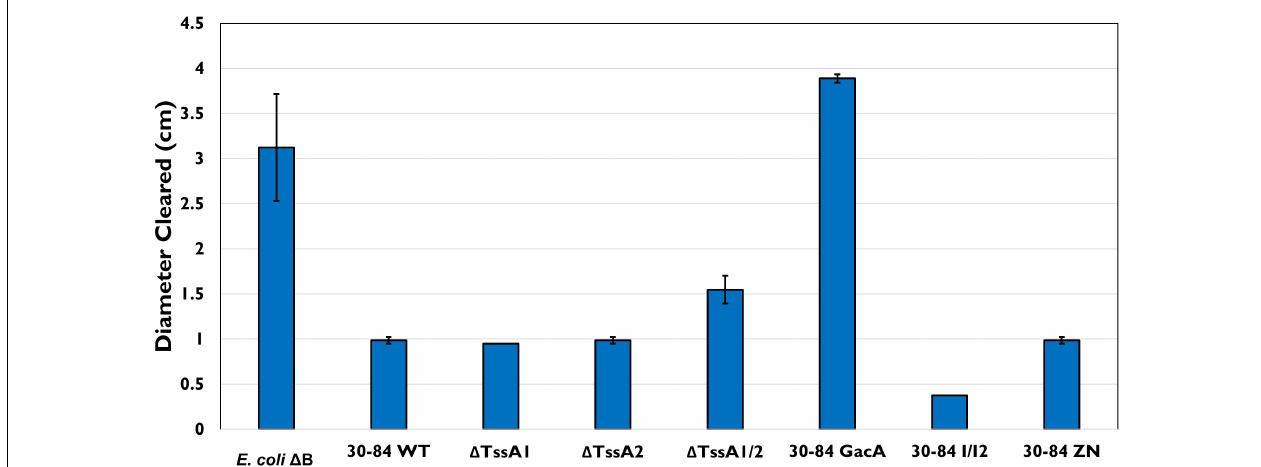
FIGURE 7 | Bacterial plate clearing by Dictyostelium discoideum. Bacteria used as prey in the feeding assay included 30–84 WT, (cid:49) TssA1, (cid:49) TssA2, (cid:49) TssA1/2, 30–84 GacA, 30–84 I/I2, or 30–84 ZN and E. coli (cid:49) B (used as a preferred prey in the lab). The diameter of bacterial lawn cleared by D. discoideum was measured in cm after 72 h. Lettering indicates significant differences. D. discoideum colonies grown on 30–84 WT, both single mutants, 30–84 I/I2, and 30–84 ZN showed little to no clearing, indicating low to no bacterial cell death. D. discoideum growing on E. coli (cid:49) B showed significant levels of clearing. When grown on 30–84 GacA, levels of clearing similar to the control were observed. When grown on (cid:49) TssA1/2, less clearing was observed than on the control, but levels were still significantly higher than clearing on 30–84 WT and the single mutants, indicating a decrease in bacterial fitness when lacking at least one functional T6SS. Data are the means and standard error (may be too small to see for some treatments) of four biological replicate experiments ( n = 4). Data were analyzed using one-way ANOVA and Student t -tests, p < 0.05.